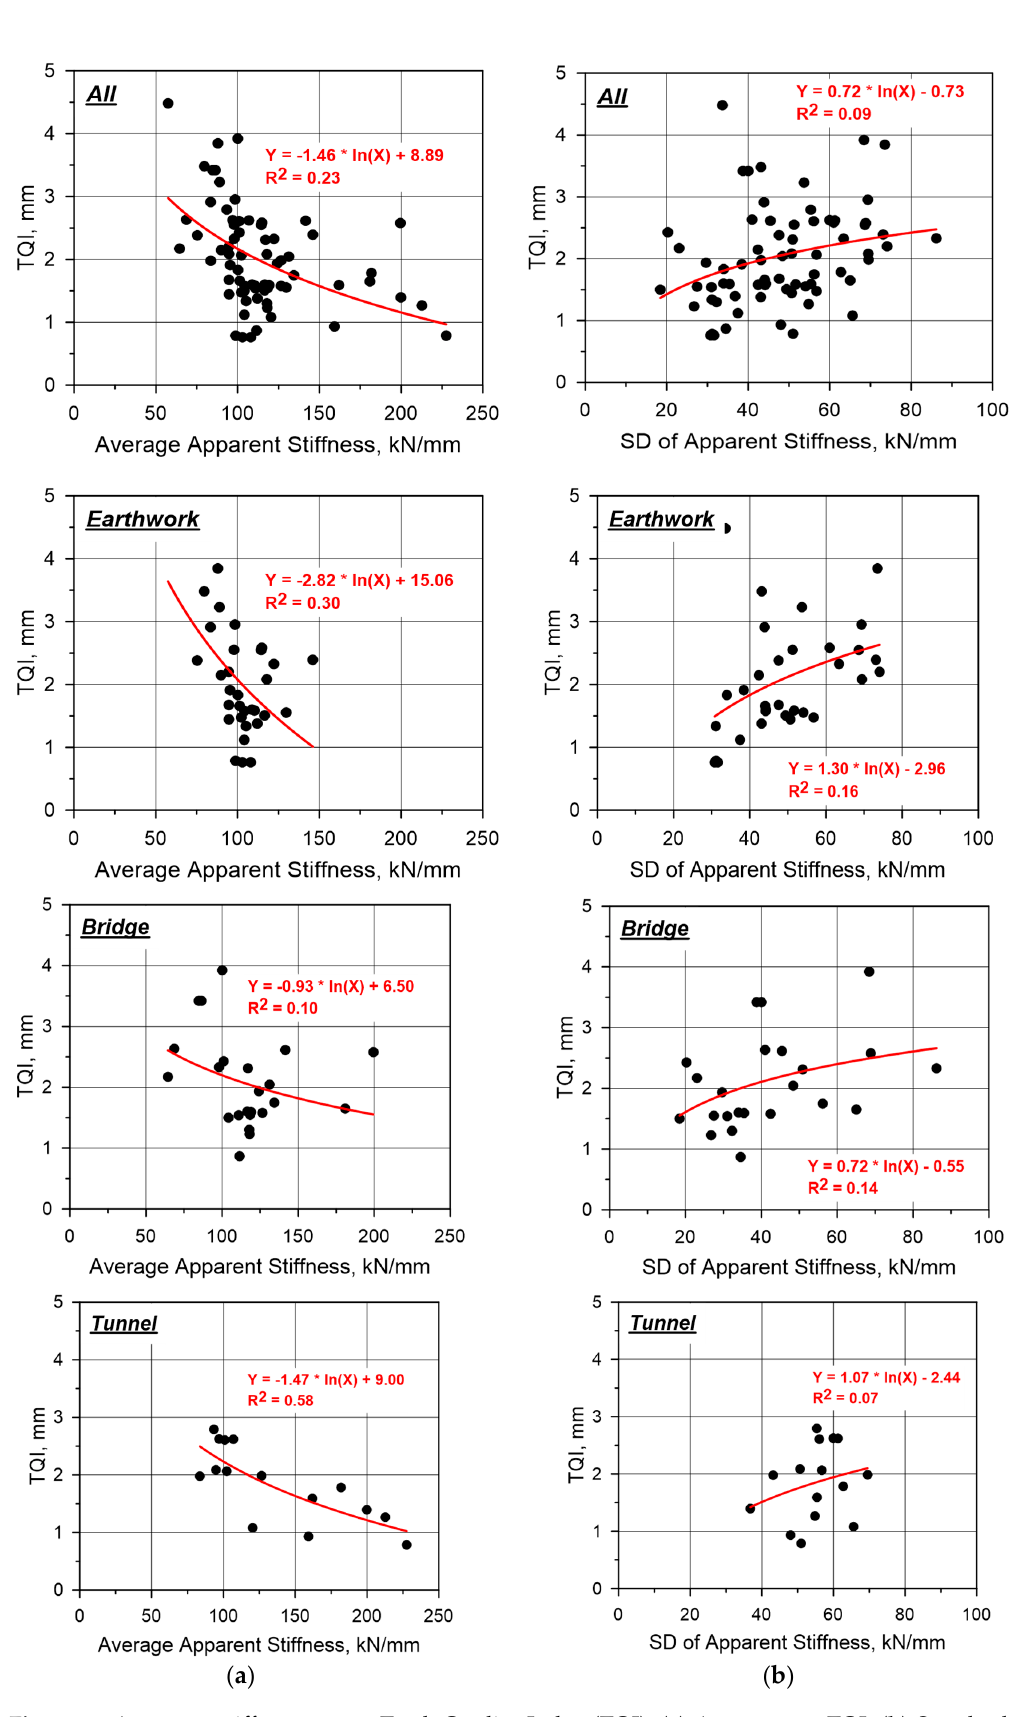
Figure 5. Apparent stiffness versus Track Quality Index (TQI): ( a ) Average vs. TQI; ( b ) Standard deviation vs. TQI.